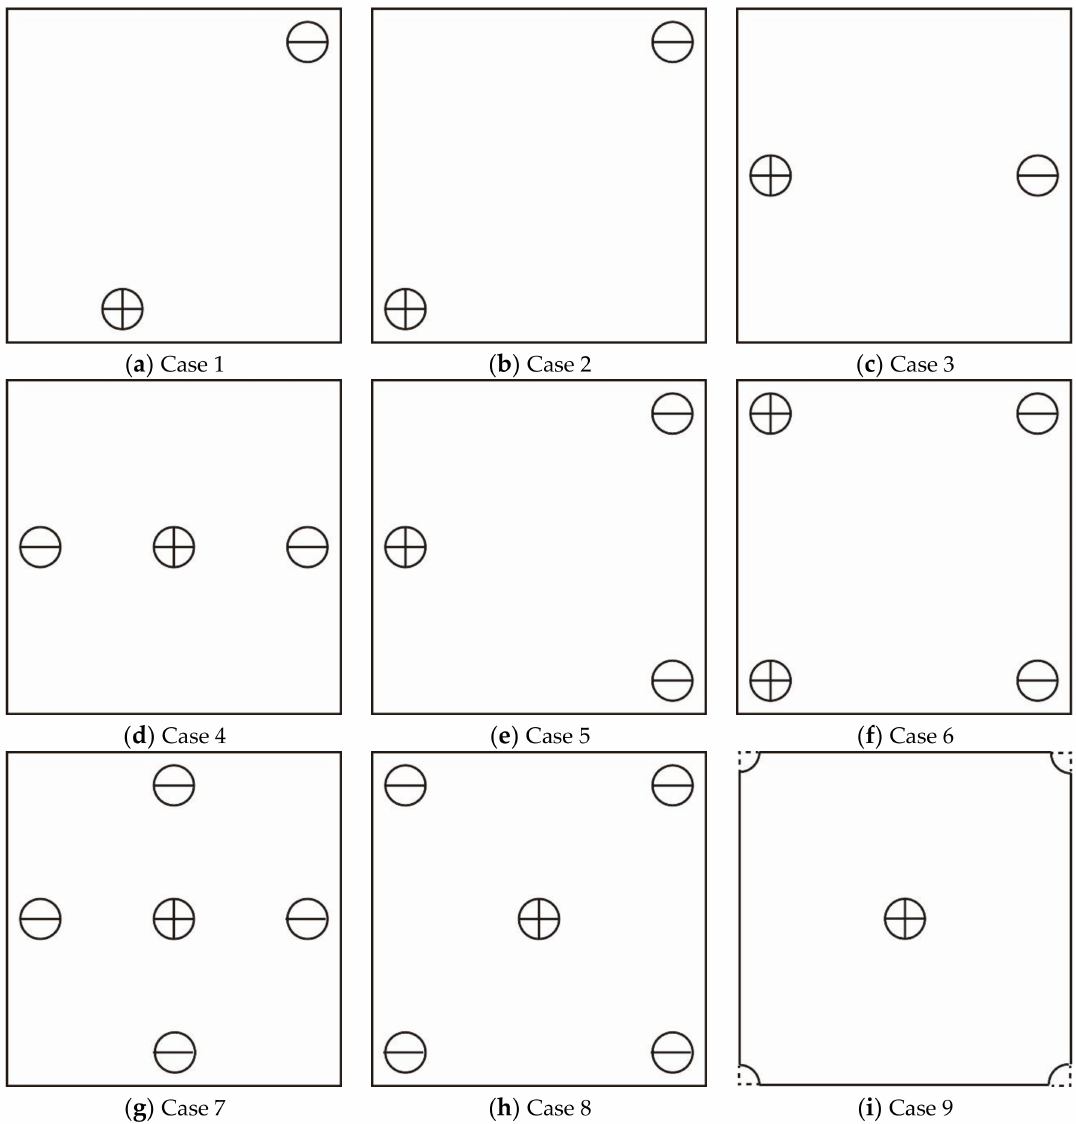
Figure 2. Schematics of nine well layout cases of enhanced geothermal systems. For all the cases, circles with positive sign represent injection wells, while those with negative sign represent production wells. Case 9 corresponds to a well array operating enhanced geothermal system [19], with four quarter production wells being located at the corners of the computational